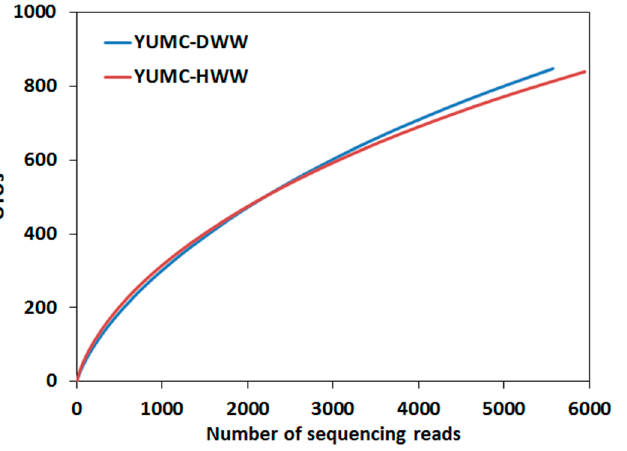
Figure 3. Rarefaction curves of OTUs clustered at 97% sequence identity for samples.